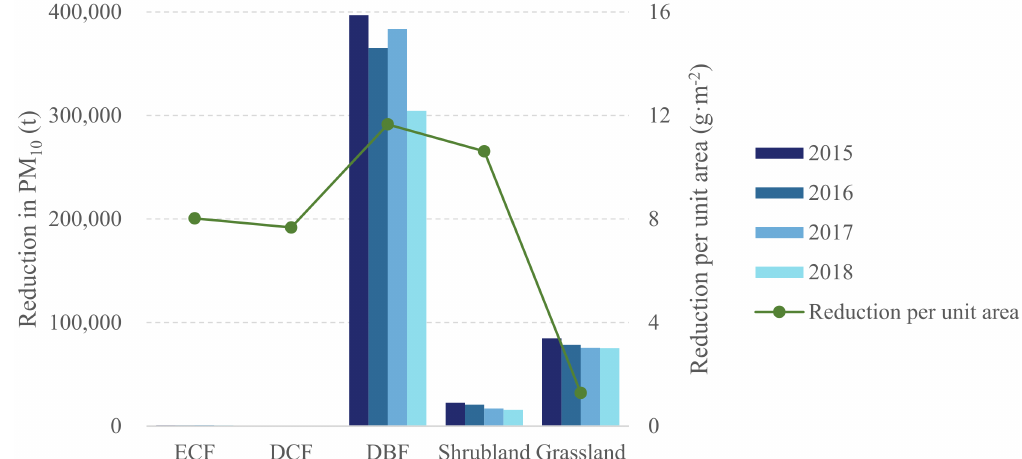
Figure 10. PM 10 removal of each vegetation type at the overall scale from 2015 to